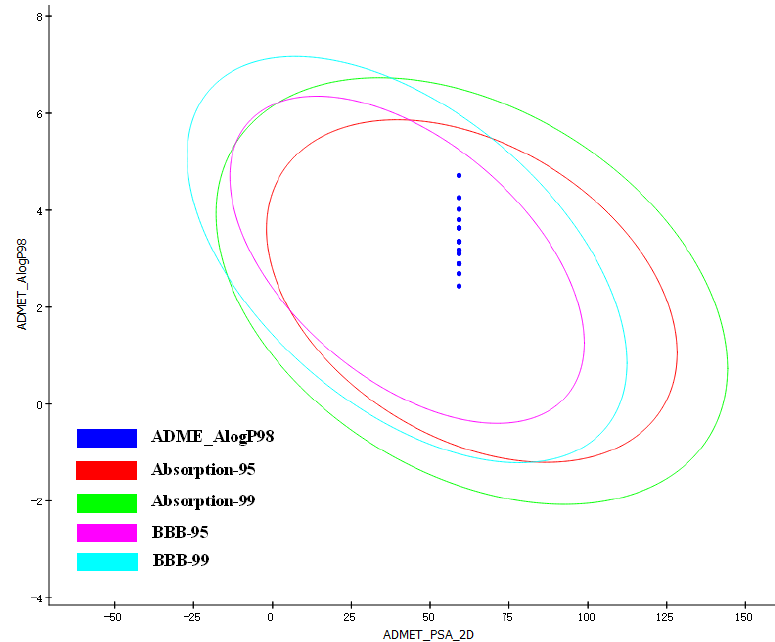
Figure 8. Target compounds 6a – u ADME/T value prediction. The blue dots in the four circular circles indicate that the compound has good pharmacokinetic properties, such as good ABS and favorable BBB permeability.